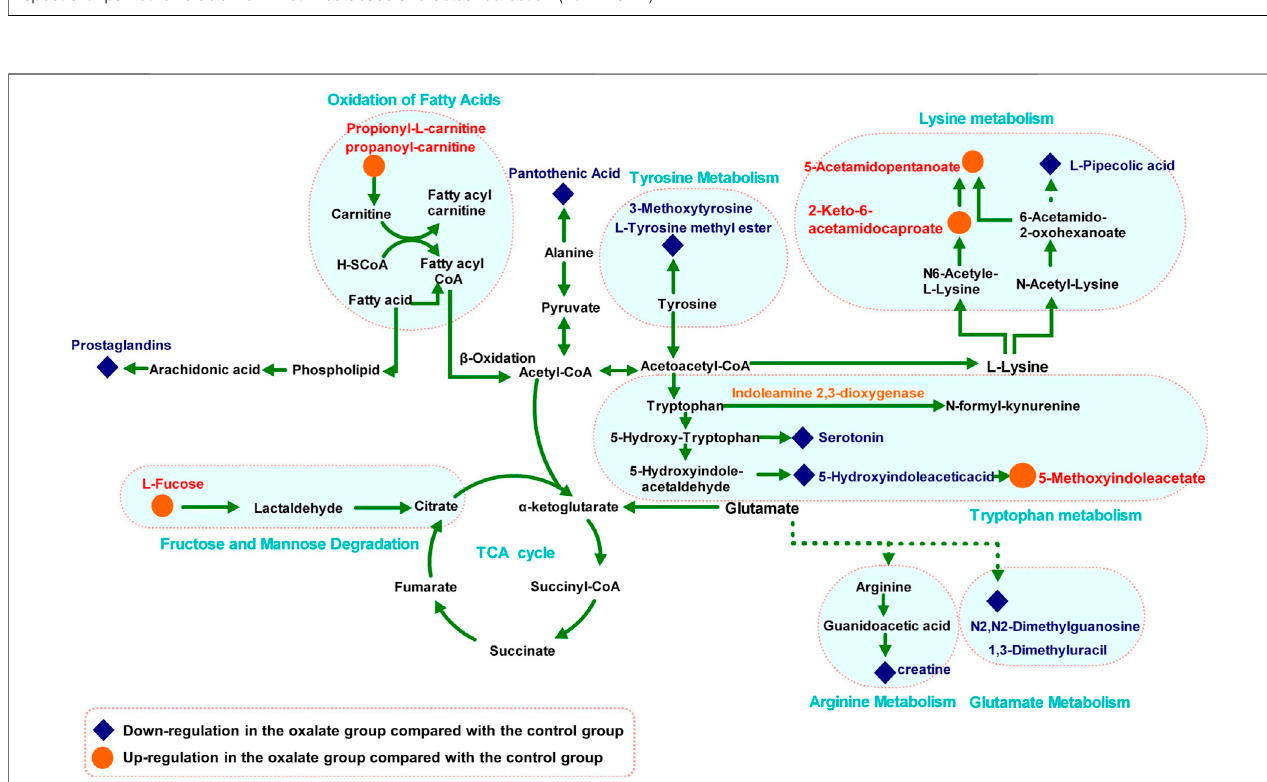
FIGURE 6 | Metabolic pathway network related to oxalate crystal-induced kidney injury. The levels of metabolites in the oxalate group compared with those in the control group are labeled in red (up-regulated) and blue (down-regulated).